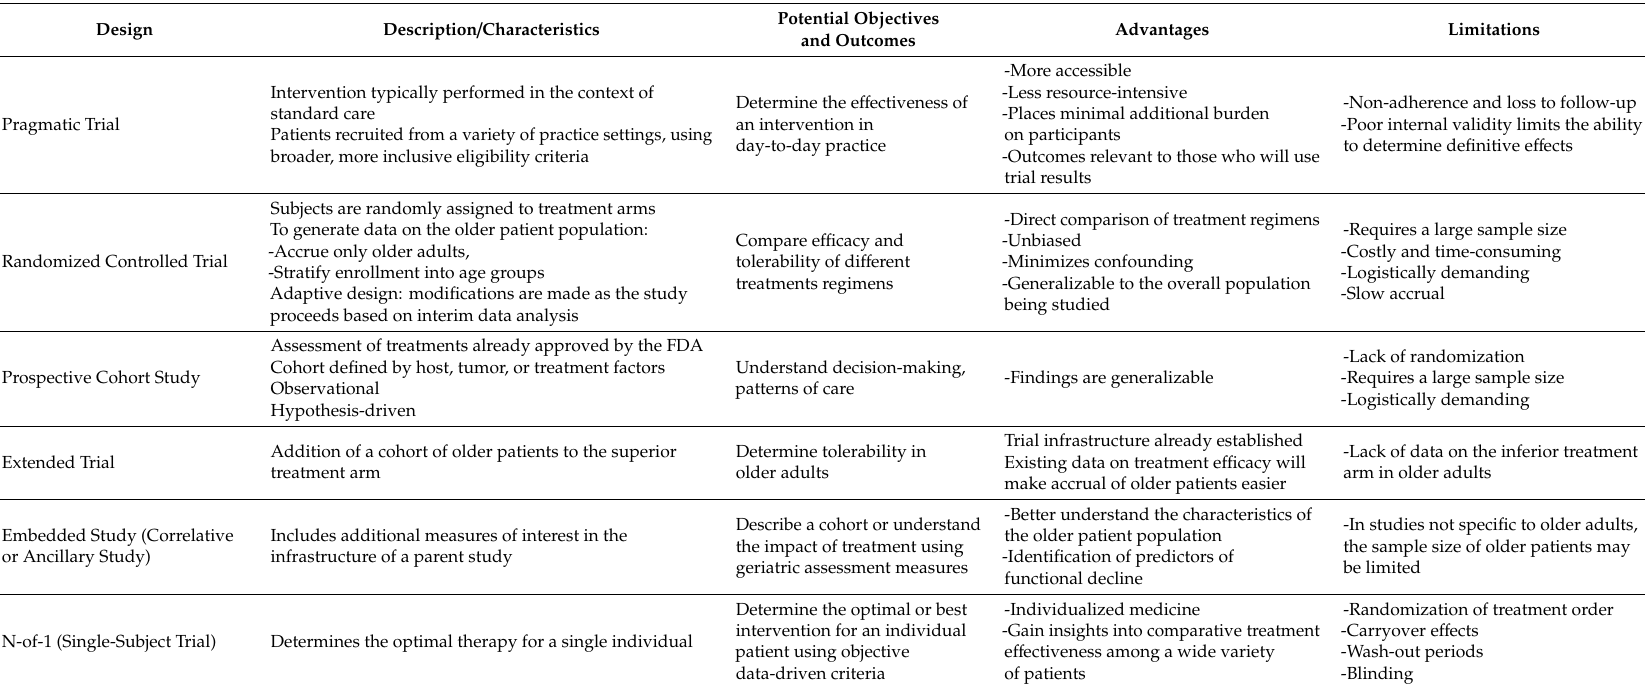
Table 1. Clinical trial designs for geriatric oncology